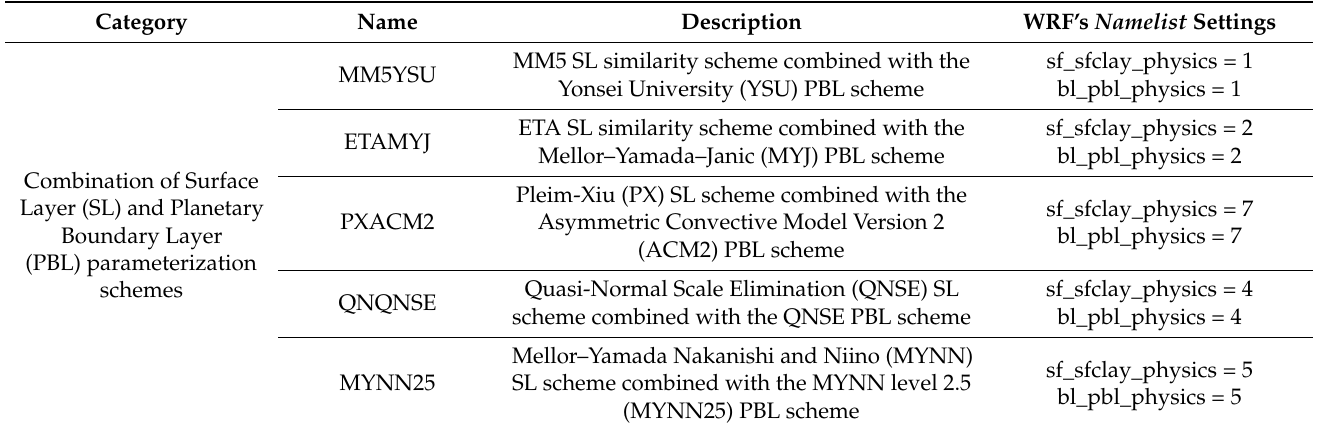
Table 1. Surface layer and PBL schemes used for the one-year wind